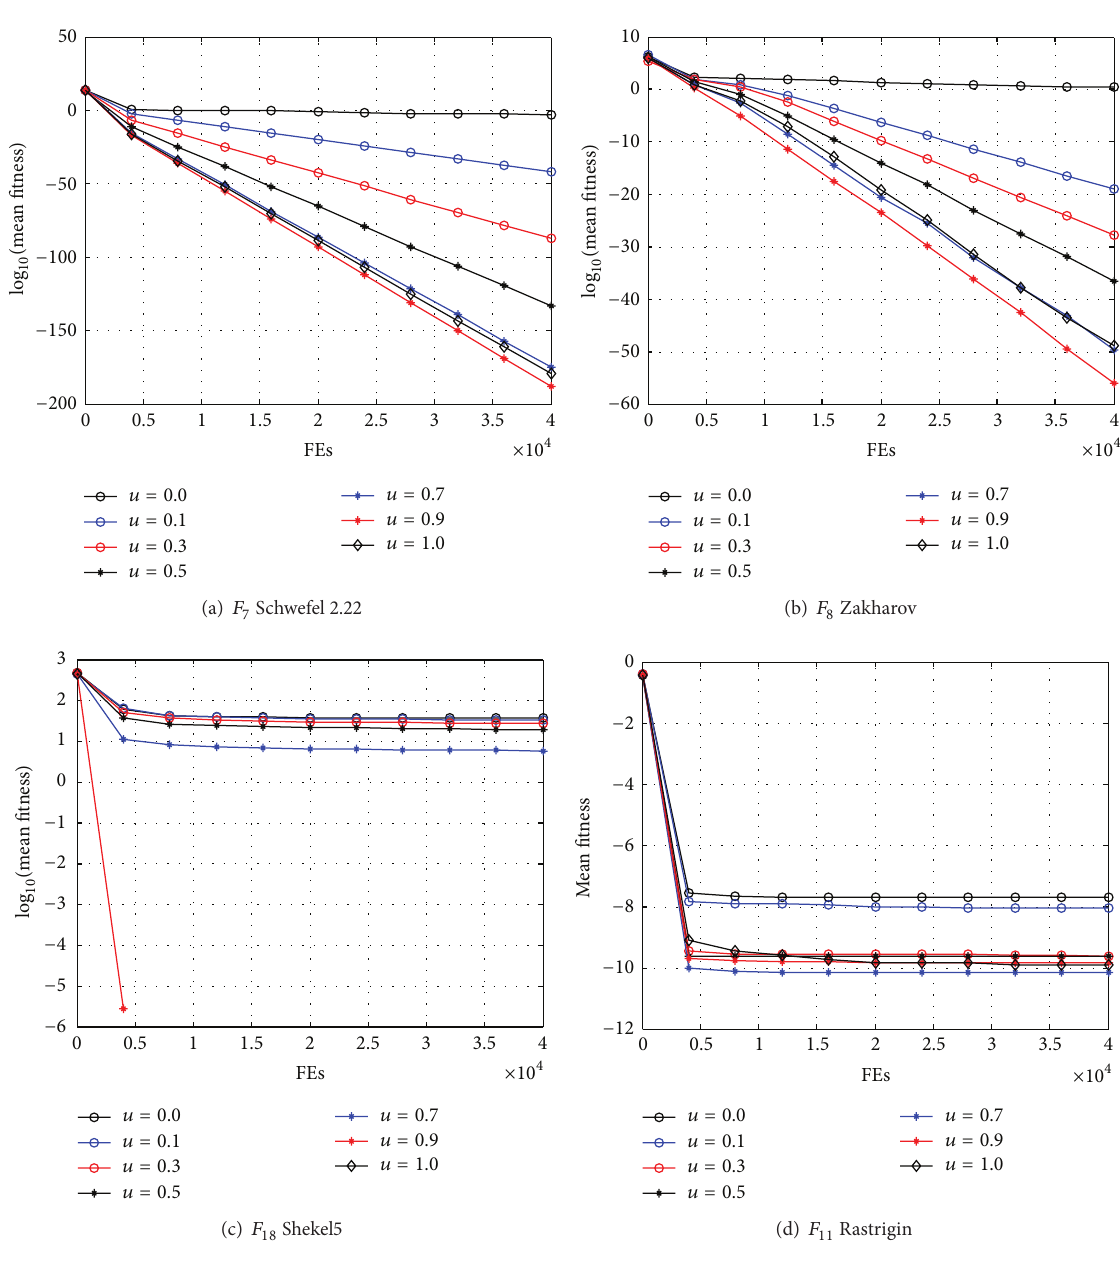
Figure 3: Comparison of the performance curves using different 𝑢